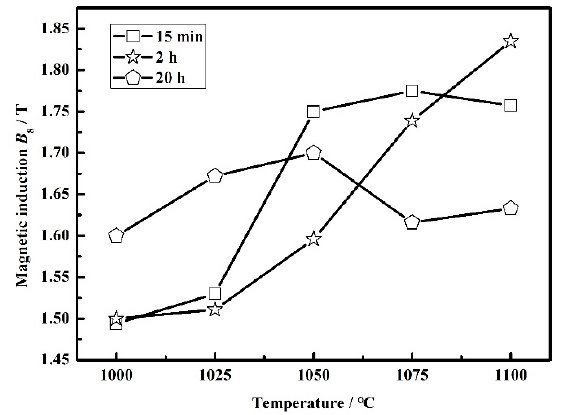
Figure 4. Magnetic induction of grain-oriented silicon steel isothermally annealed at different temperatures for 20 min.